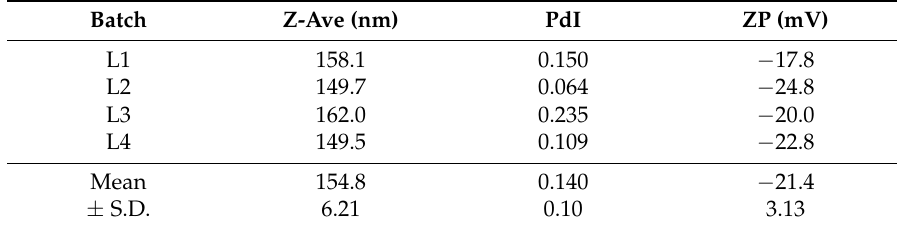
Figure 3. Dimensional distribution of the four batches of unloaded nanoparticles. Table 1. Mean particle size (Z-Ave), polydispersity index (PdI), and Zeta potential (ZP) values for unloaded nanoparticles.